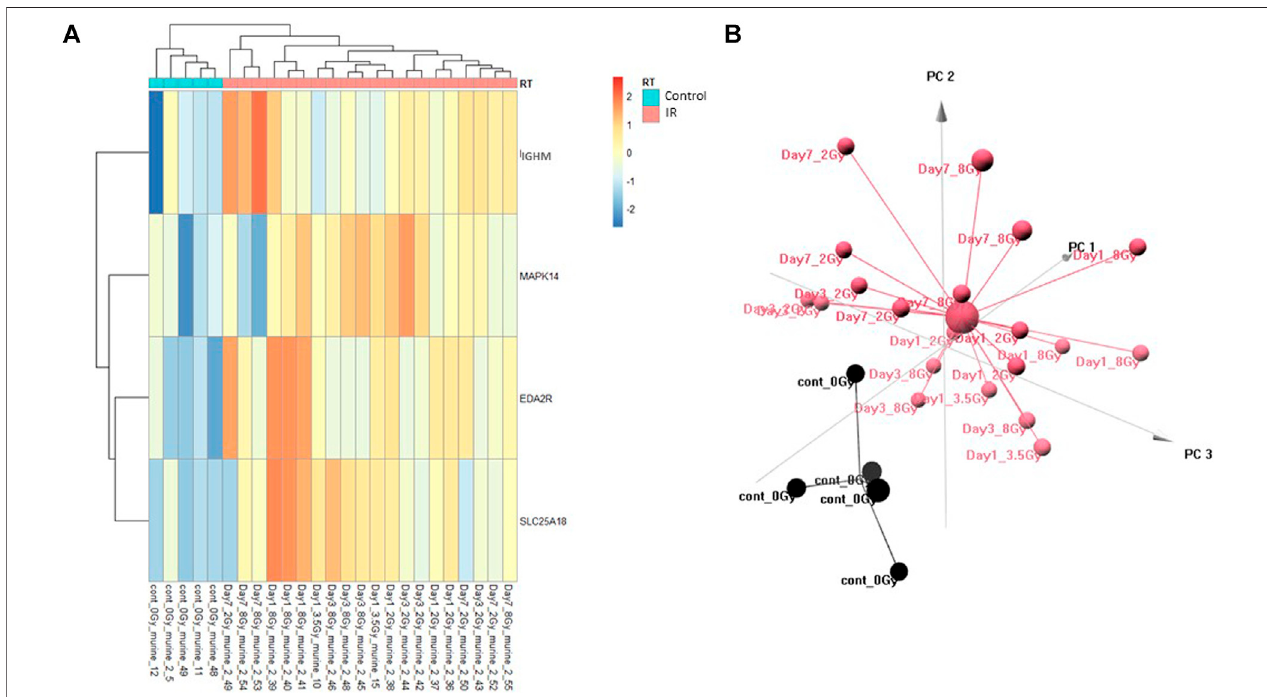
FIGURE1 | Control vs. RT Training Model. Analysisofproteomic expression within the sample cohort used for model building oftheControlvs. RTTraining model using top selected proteins IGHM, MAPK14, EDA2R and SL25A18. Findings are represented by (A) heatmap and (B) PCA.